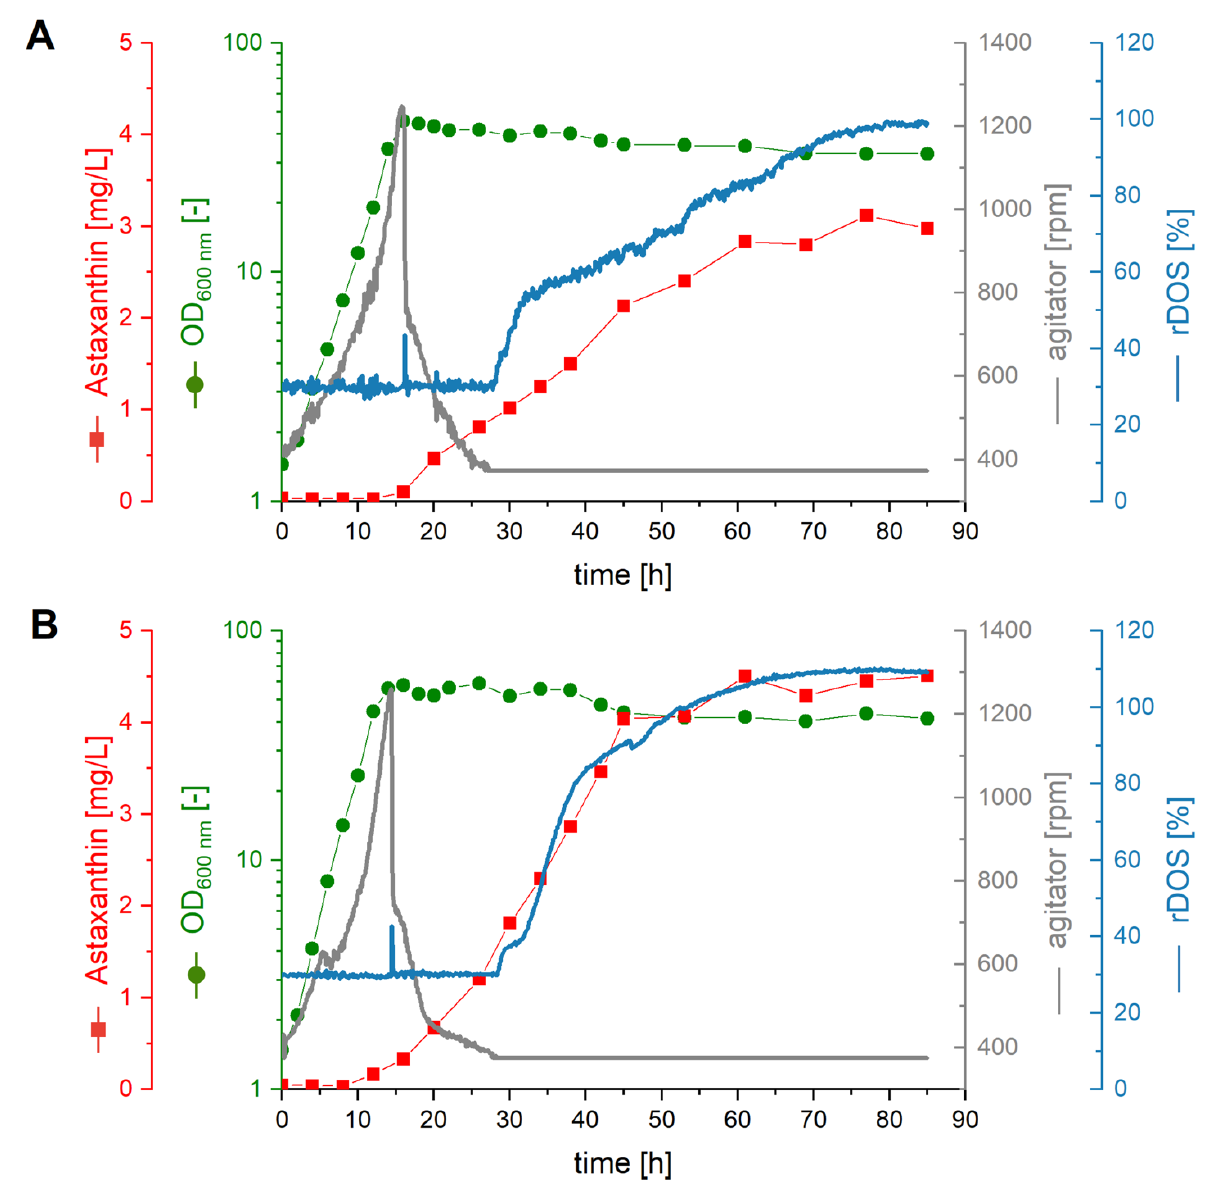
Figure 5. Batch-Fermentations. Progression of astaxanthin content (red squares), OD 600 nm (green dots), agitator speed (grey line), and relative dissolved oxygen concentration (rDOS) (blue line) over time during 2 L batch fermentations with C. glutamicum ASTA* grown in CGXII medium ( A ) and CGXII medium supplemented with 20% ( v / v ) AQ ( B ).